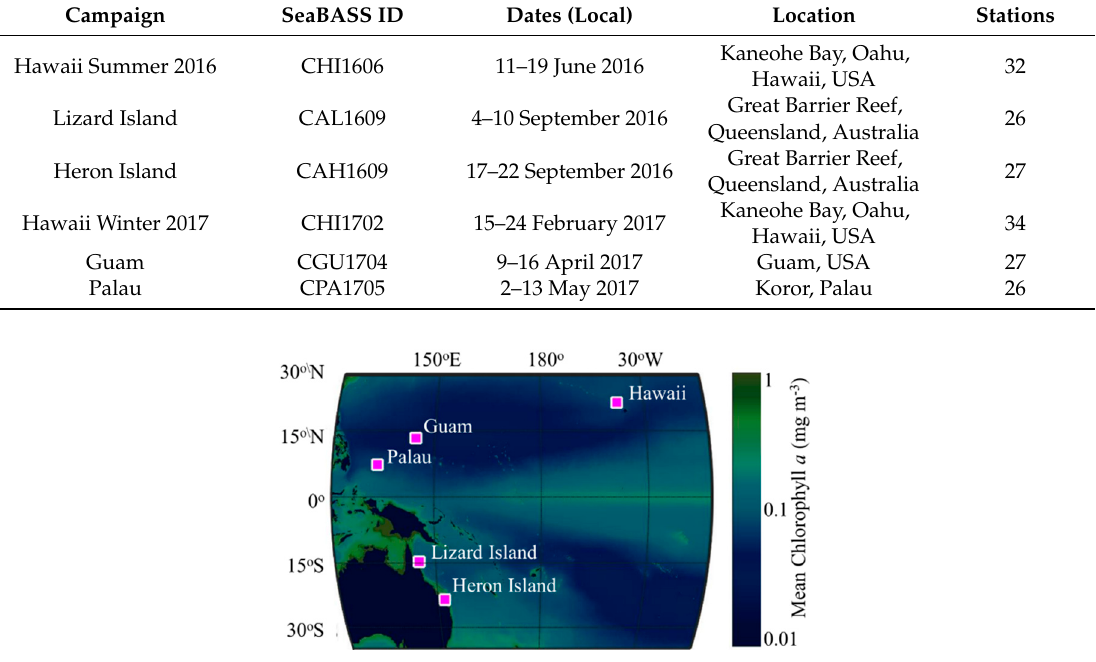
Figure 1. Location of COral Reef Airborne Laboratory (CORAL) in-situ validation efforts overlain on a MODIS mission climatology of Chlorophyll a .